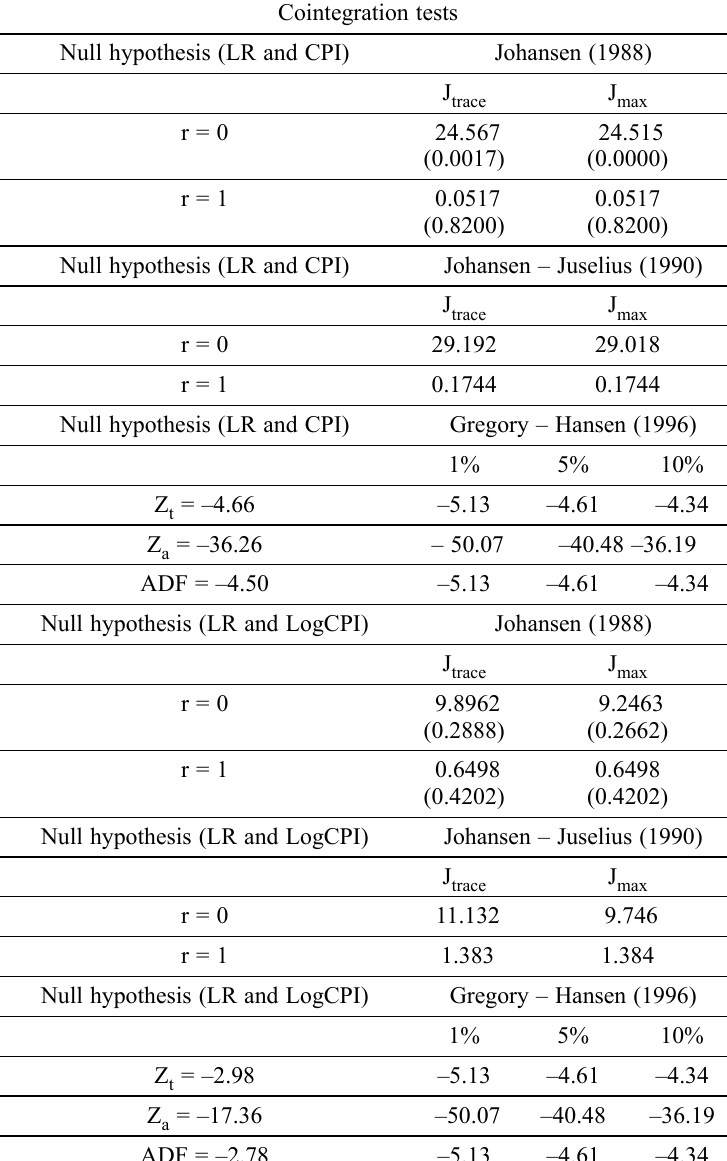
Table 5 . Cointegration test results for the series LR, CPI,